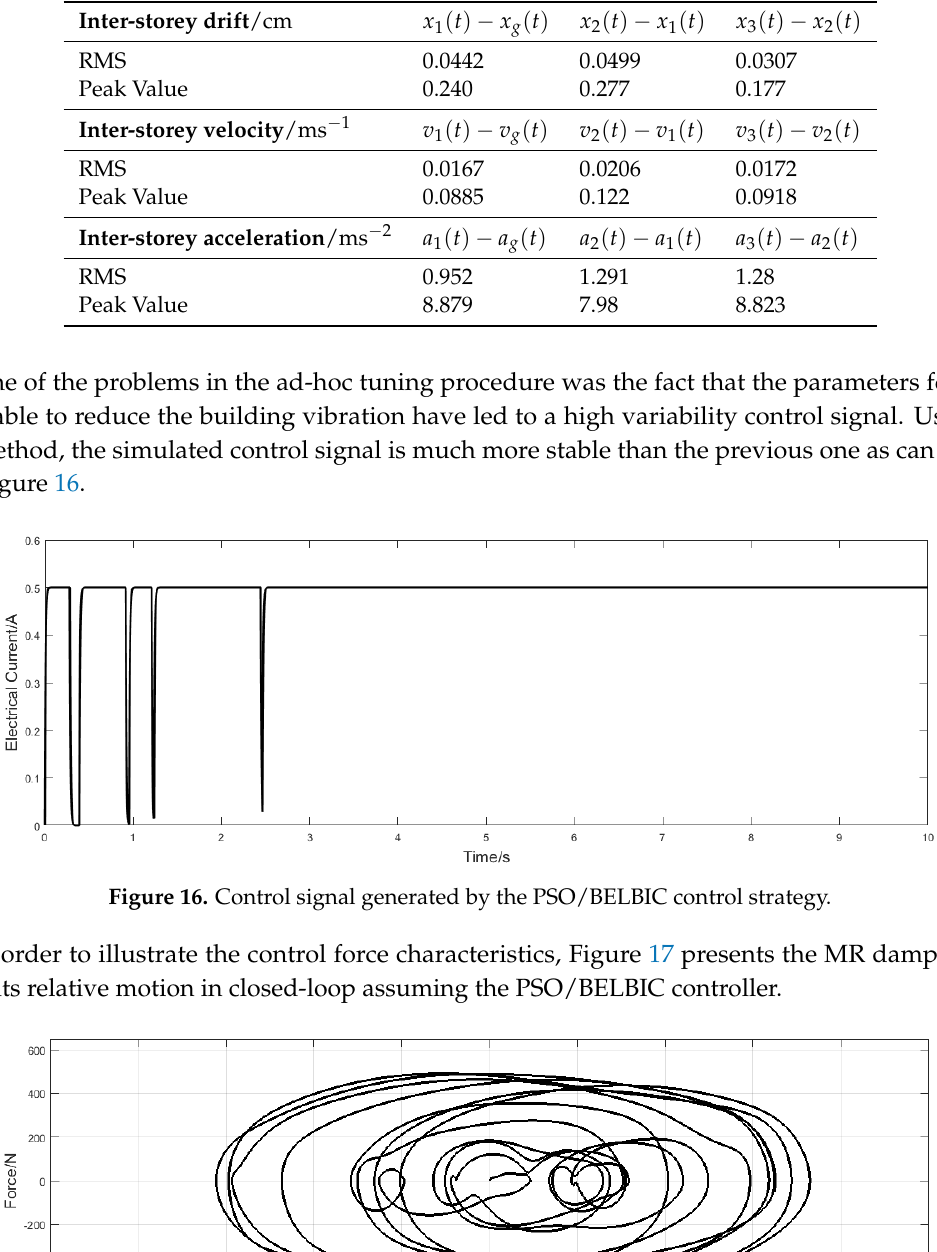
Table 5. Closed-loop RMS and peak values assuming an PSO tuned BELBIC controller.